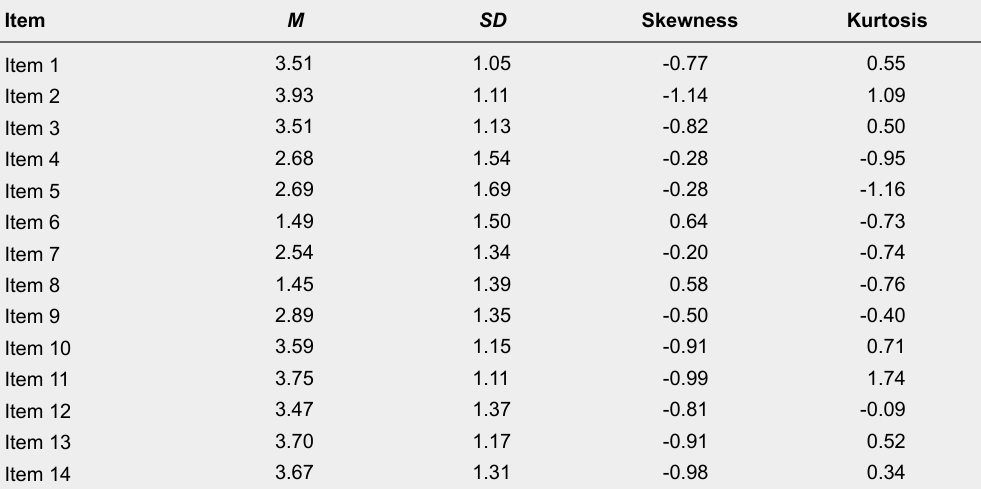
MHC. Descriptive Univariate